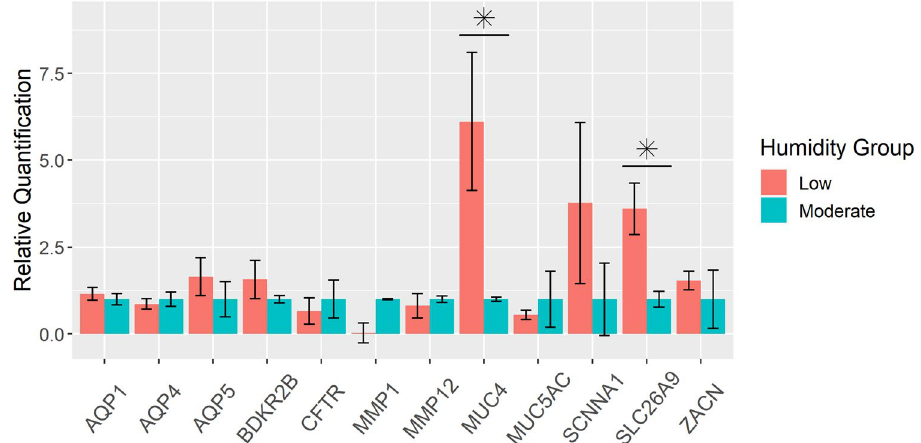
Figure 4. RT-qPCR for differential gene expression. Relative quantification for each gene was determined by the 2 (−ΔΔCt) method (n = 6 per humidity group except for three outlying values removed). HPRT1 was used as an endogenous control. Individual ΔΔCt was calculated for each sample using the average ΔCts from the moderate humidity group for the respective gene. Data are reported as aggregated means of 2 −ΔΔCt with standardized values for the moderate humidity group. Standard errors of the mean are represented by the error bars and were calculated from individual sample values. MUC4 (p = 0.019) and SLC26A9 (p = 0.009) exhibited significantly different expression between humidity groups. SCNNA1 exhibited a substantial fold change of expression but failed to reach statistical significance (p = 0.095).